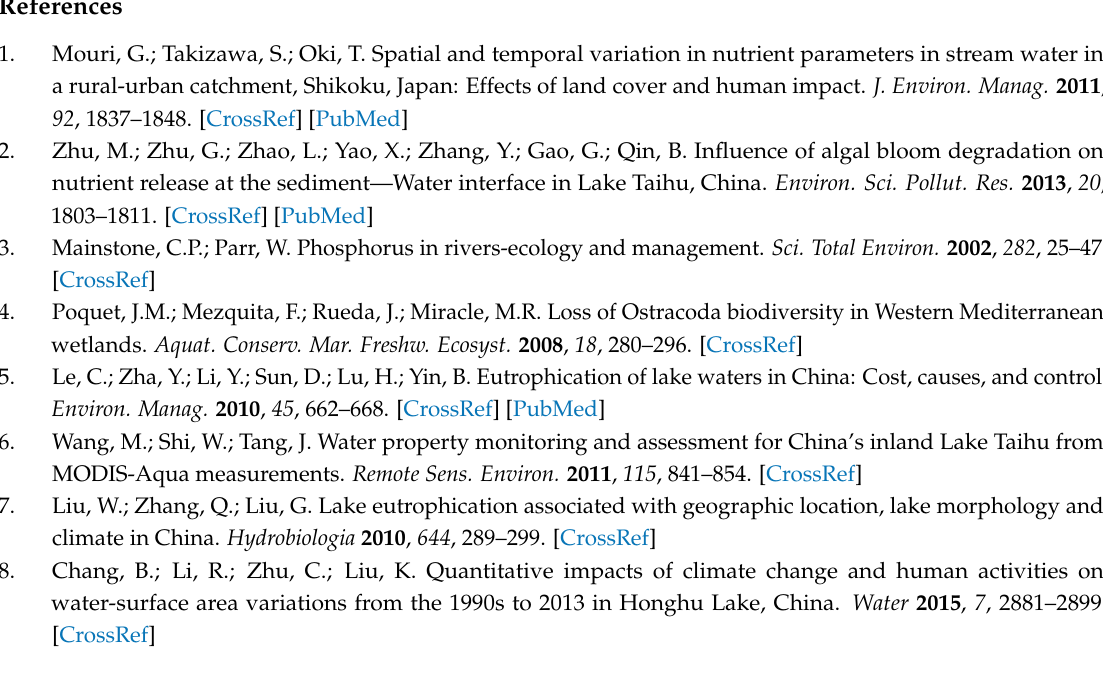
Table S1: The mean values of raw date for water quality parameters at all sampling sites in 14–15 April 2013 (dry season), Table S2: The mean values of raw date for water quality parameters at all sampling sites in 20–21 August 2012 (wet season), Table S3: The mean values of raw date for water quality parameters at all sampling sites in 12–13 December 2012 (normal season), Table S4: Summary statistics of measured variables for Honghu Lake during dry, wet and normal seasons, Table S5: Summary statistics of submerged aquatic plants biomass (g) for Honghu Lake during dry, wet and normal seasons.